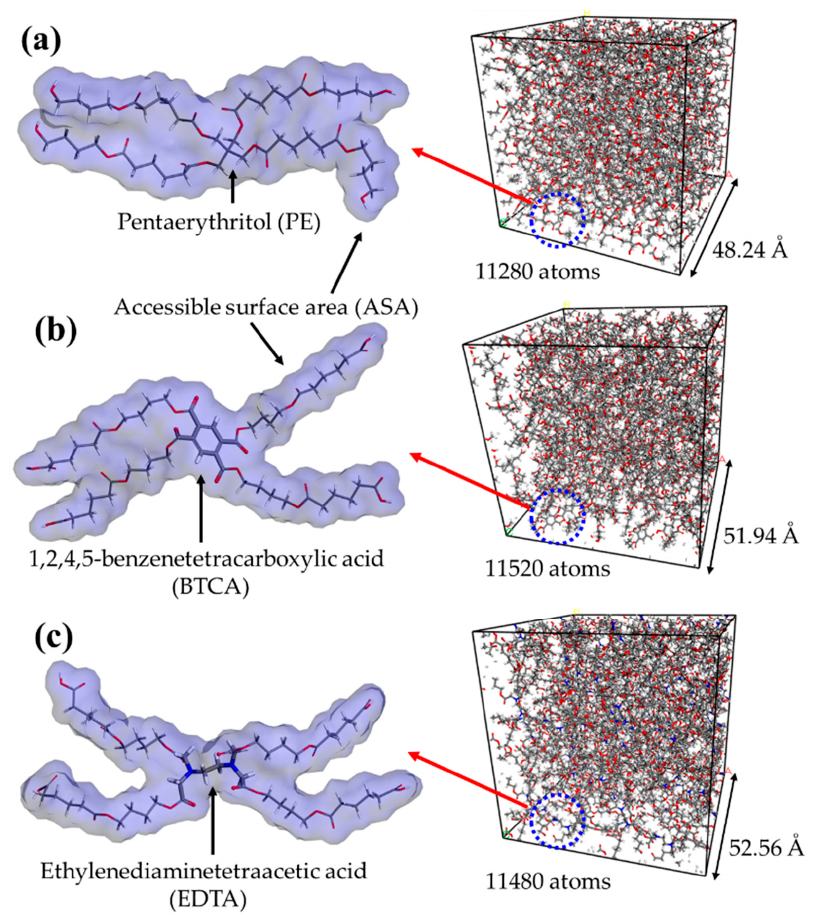
Figure 10. Snapshot of PBABI copolyester with ( a ) PE, ( b ) BTCA, and ( c ) EDTA as a modifier. Left: the molecular chain conformation, the modifier in the center of PBABI copolyesters. Right: the PBABI models with different modifiers. (Color: H, C, N, and O are presented in white, grey, blue, and red, respectively.) the accessible surface area is shown in a light blue color.